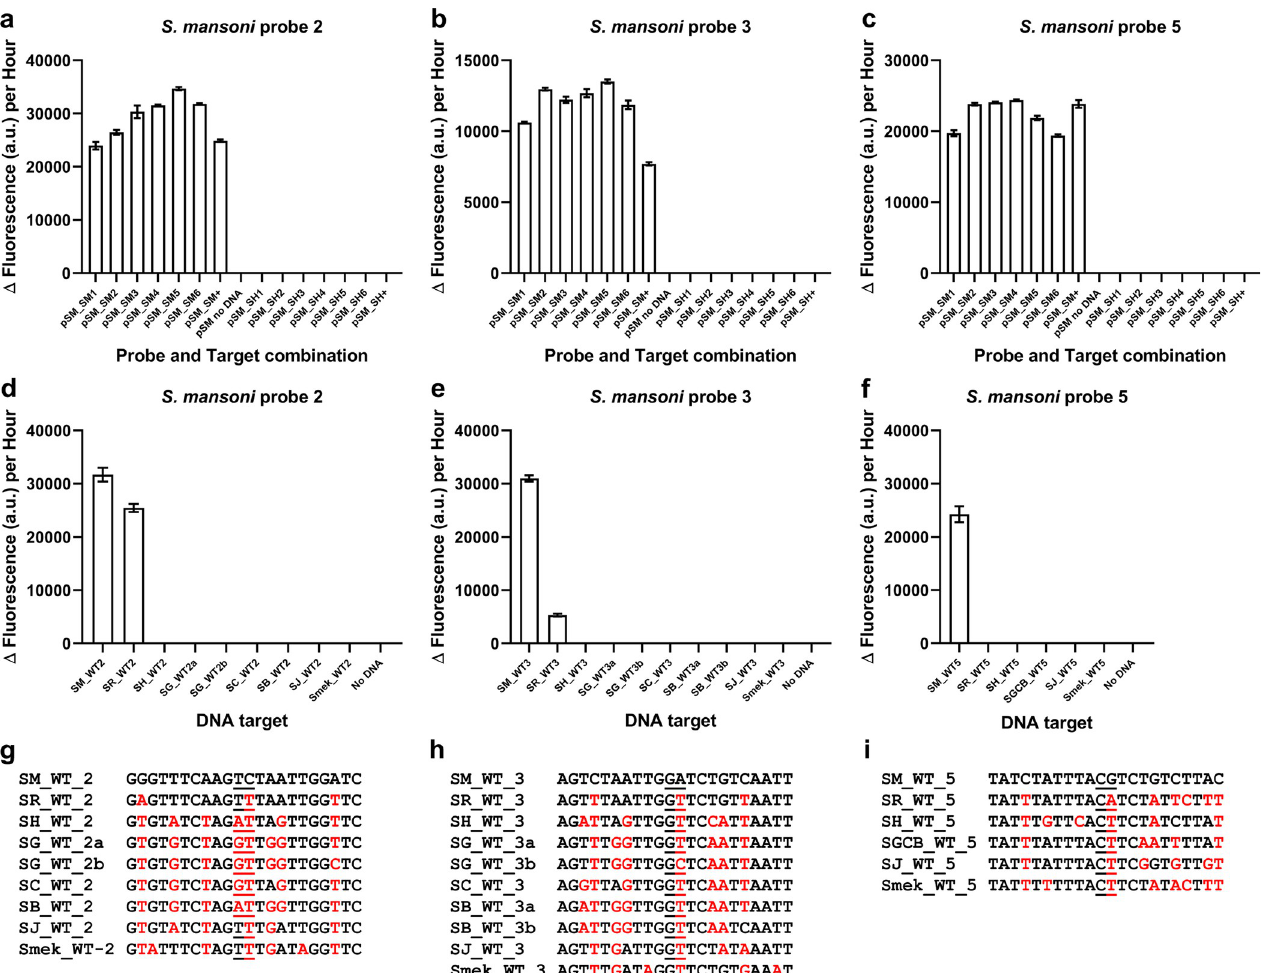
Fig 5. Validation of re-iterated S . mansoni -specific probes. a, b & c , Re-iterated S . mansoni -specific probe set designs 2, 3 and 5 respectively, only recognised and bound to S . mansoni -specific target ssDNA. 50 nM of each probe half was incubated with 30 ng of the purified ssDNA samples used in Fig 4D & 4E. Reactions are identified as follows: pSM_SM1-6 ( S . mansoni probes against S . mansoni plasmid derived ssDNA), pSM_SM+ ( S . mansoni probes against S